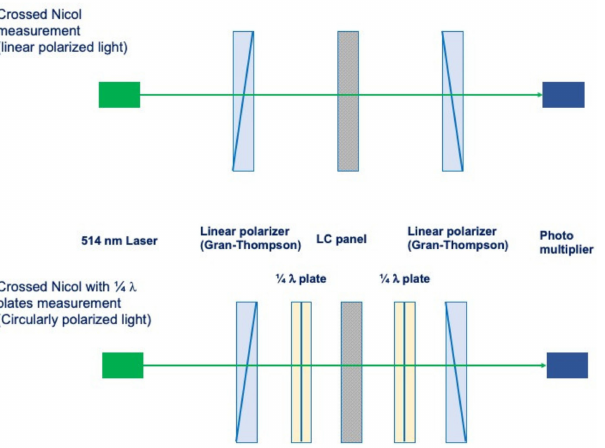
Figure 2. Two measurement set-ups: one uses a linearly polarized beam, the other uses a circularly polarized